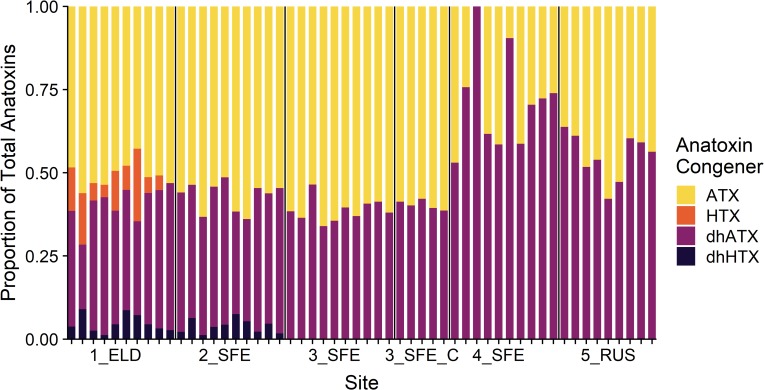
The composition of anatoxin congeners from attached periphyton samples collected at the five sites.Each vertical bar represents one periphyton sample and the vertical black lines delineate each site. 3_SFE_C represents Cladophora-dominated samples at site 3_SFE. ATX = anatoxin-a, HTX = homoanatoxin-a, dhATX = dihydroanatoxin-a, dhHTX = dihydrohomoanatoxin-a.